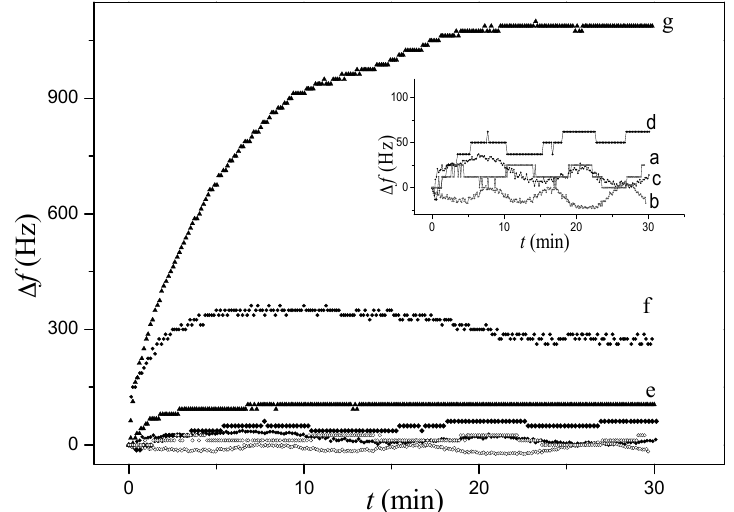
Figure 2. Typical [bmim][BF 4 ]-modified QCM sensor response curves to different concentrations of acetone vapor: ( a ) 0; ( b ) 5.64; ( c ) 7.05; ( d ) 9.40; ( e ) 28.20; ( f ) 65.80; and ( g ) 329 ppmv. The inset figure is the enlargement of the curves at the bottom.